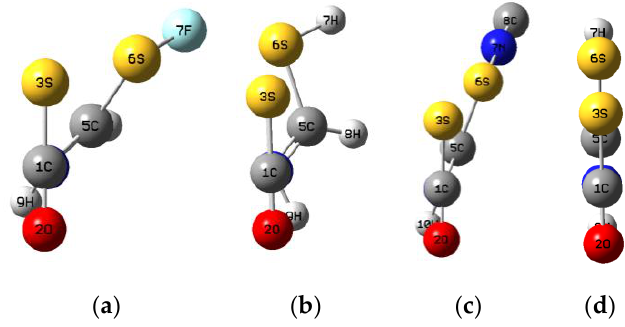
Figure 1. HN(CH)SX:SCO complexes with X = ( a ) F, C 1 ; ( b ) H, C 1 ; ( c ) NC, C 1 ; and ( d ) H, C s .